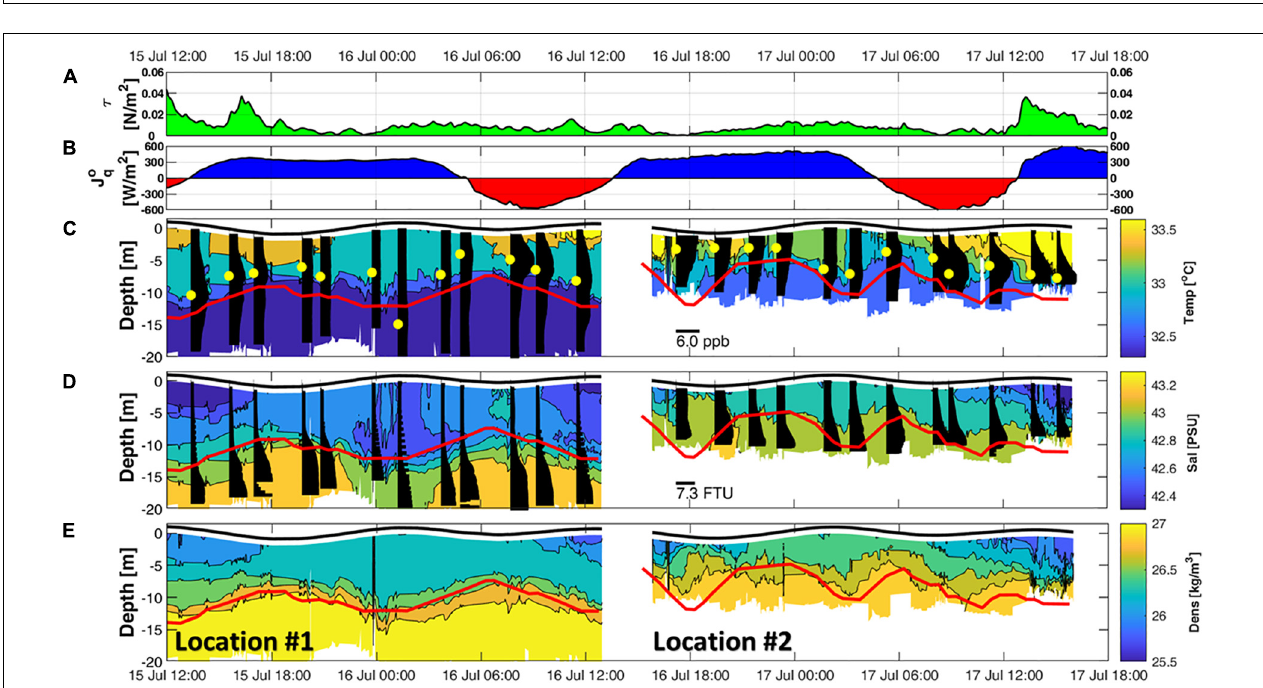
FIGURE 5 | Phase averaged currents from 15 to 27 July 2017, averaged from locations #1 and #2. (A) Depth averaged vertical velocity; (B) E–W velocity; (C) N–S velocity; (D) horizontal speed. (E) Vertical shear of horizontal current. The time in the upper axis indicates hours into the M 2 tide.